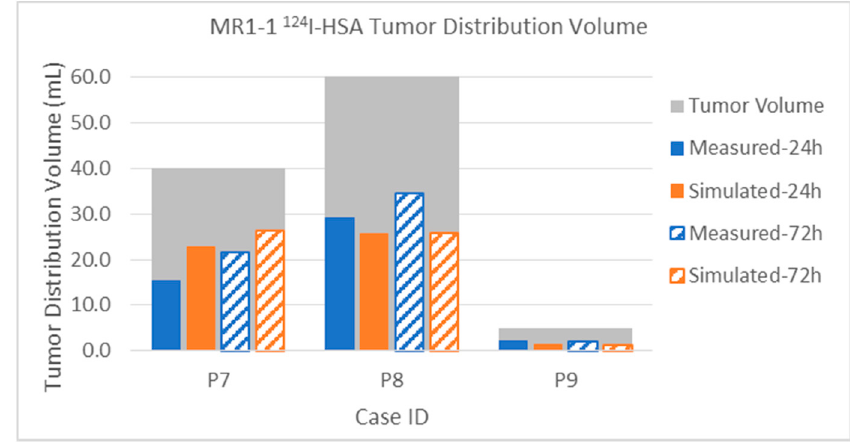
Figure 14. Comparison of measured and simulated 124 I-HSA distribution within contrast-enhancing tumor in MR1-1 patients. Gray bars show tumor volume.